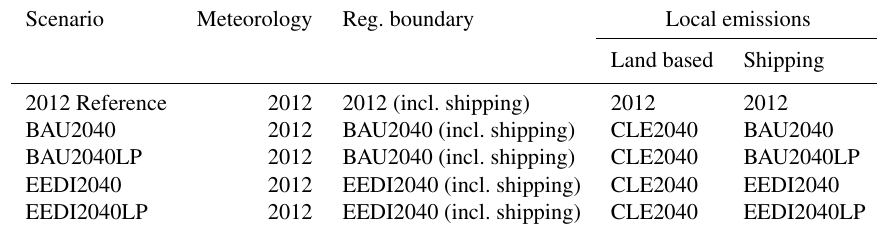
Table 2. Meteorology, regional boundary conditions, and emissions setup for the calculated scenarios.